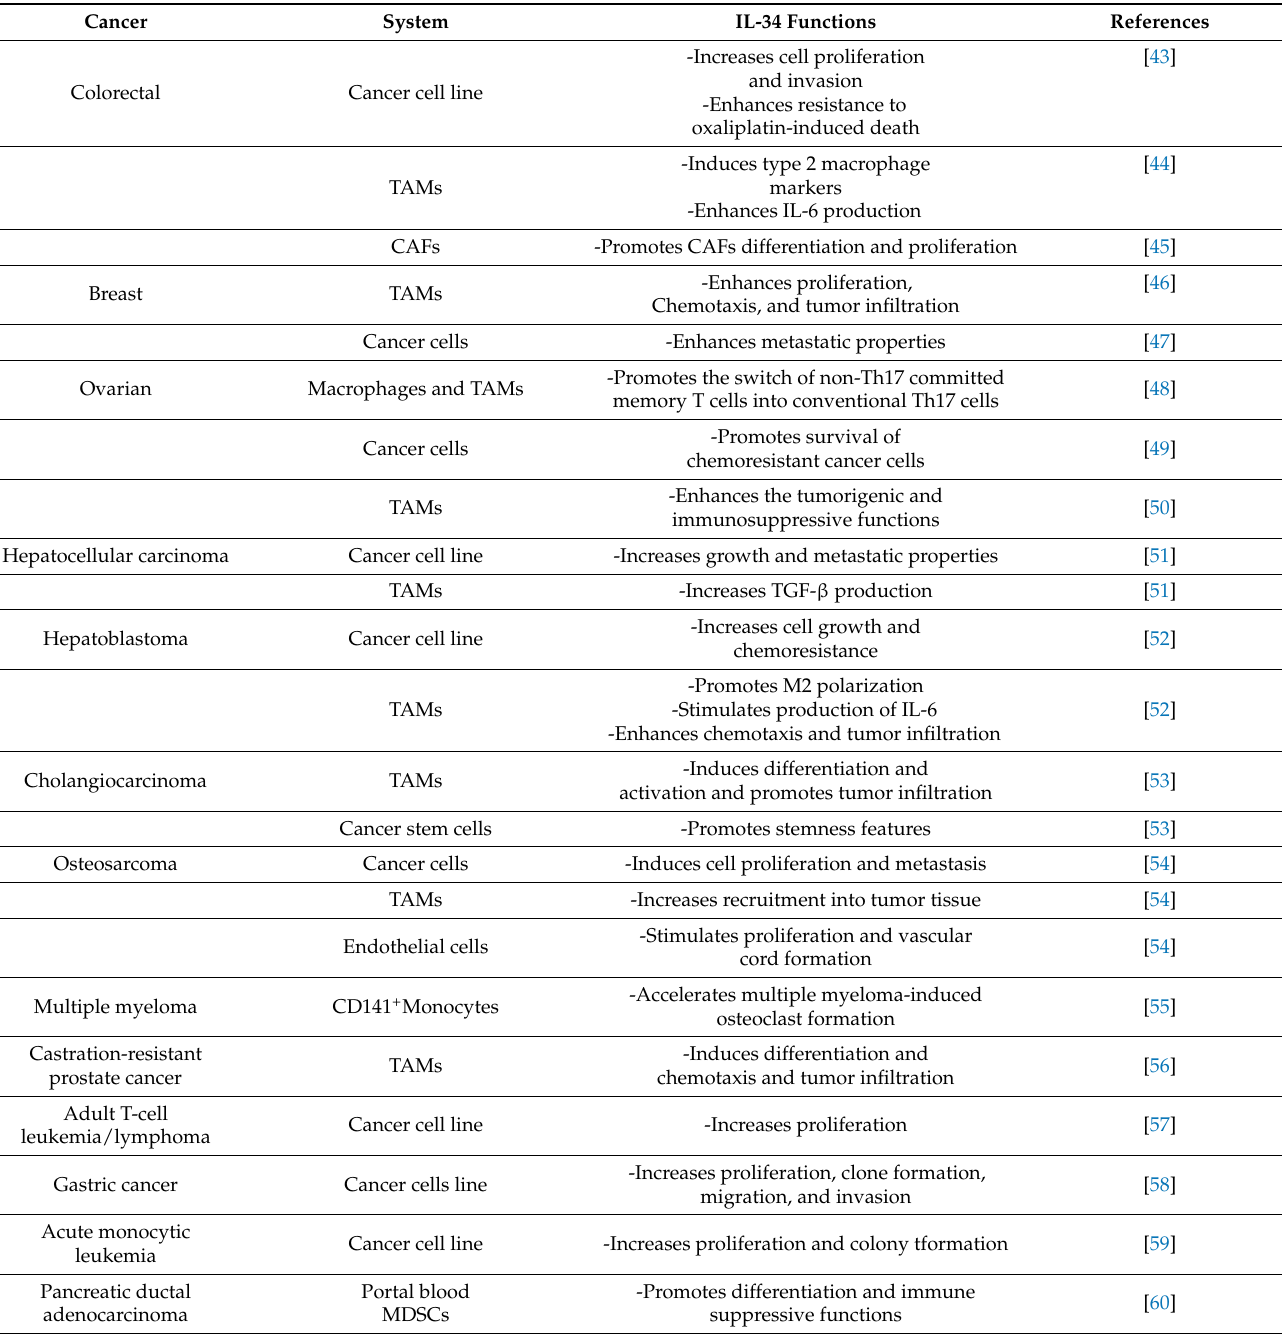
Table 1. Expression and function of IL-34 in various human